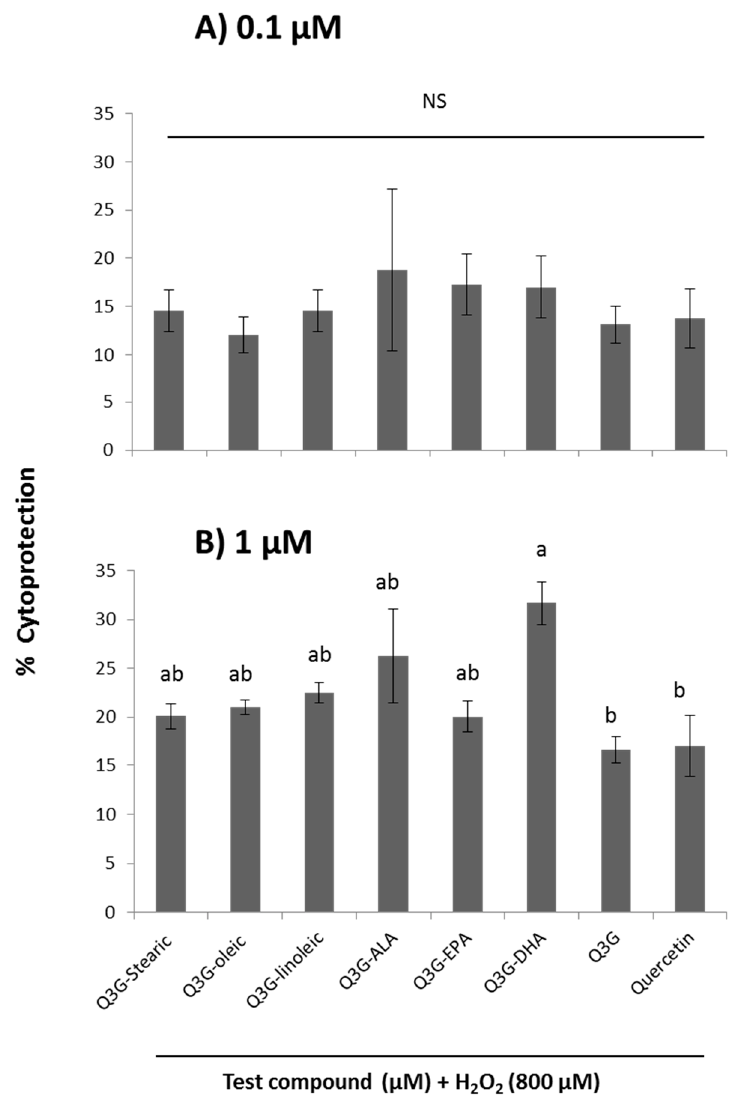
Figure 6. Dose-dependent cytoprotective effect of six fatty acid esters of Q3G, Q3G and quercetin using release of LDH under H 2 O 2 -induced oxidative injury in WI-38 cells. Cells were pre-incubated with test compounds at 0.1 µM ( A ) and 1 µM ( B ) followed by oxidative injury with H 2 O 2 for 3 h. Data were expressed as mean ± SEM ( n = 3), means sharing the same letter within concentration are not significantly different ( p ≤ 0.05).